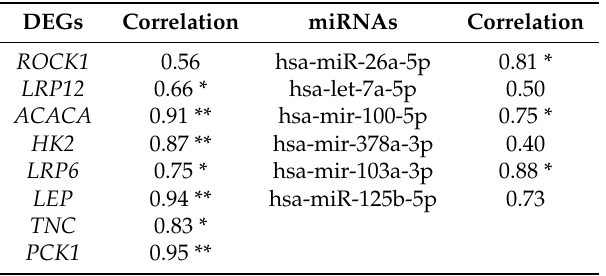
Table 6. Correlation coe ffi cients for NGS results and qPCR data for both miRNAs and DEGs. DEGs Correlation miRNAs Correlation ROCK1 0.56 0.66